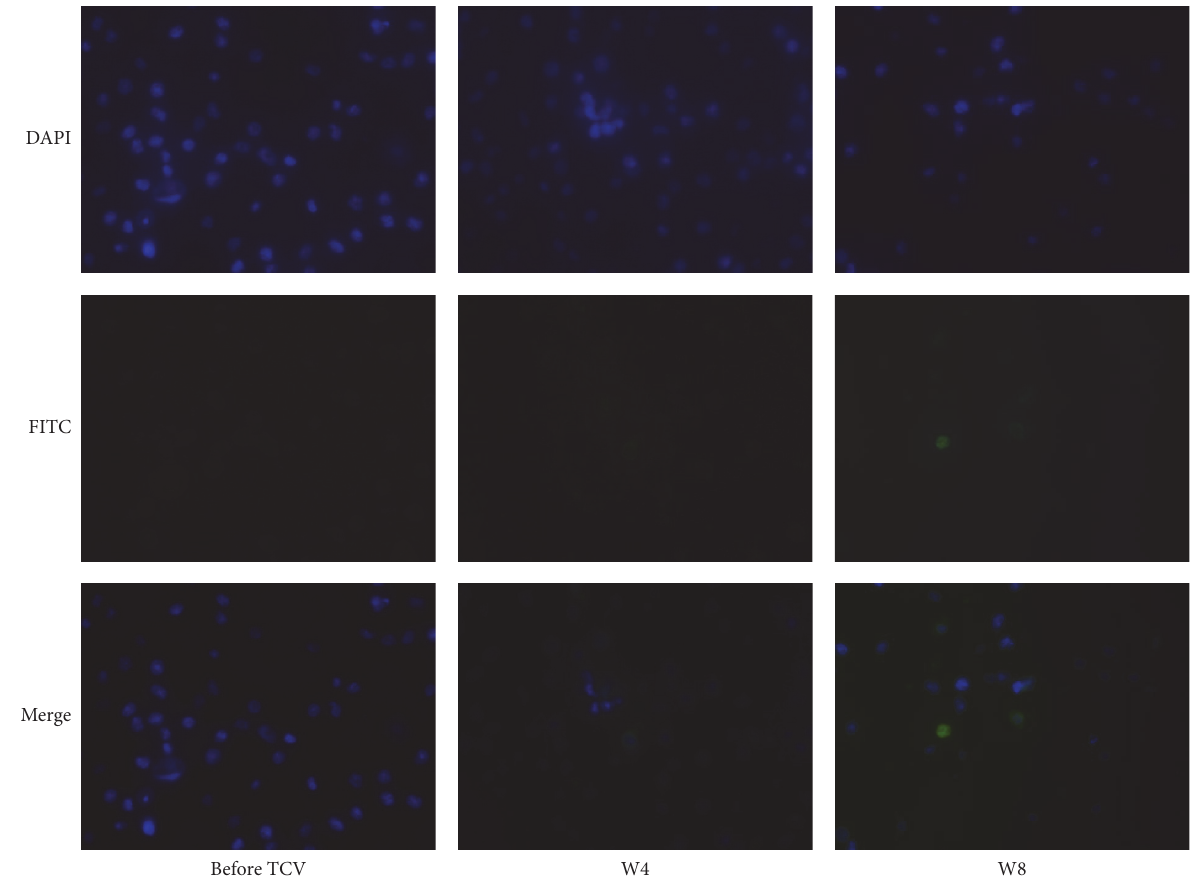
Figure 2: The changes in antiautoreactive T cell antibodies of periphery